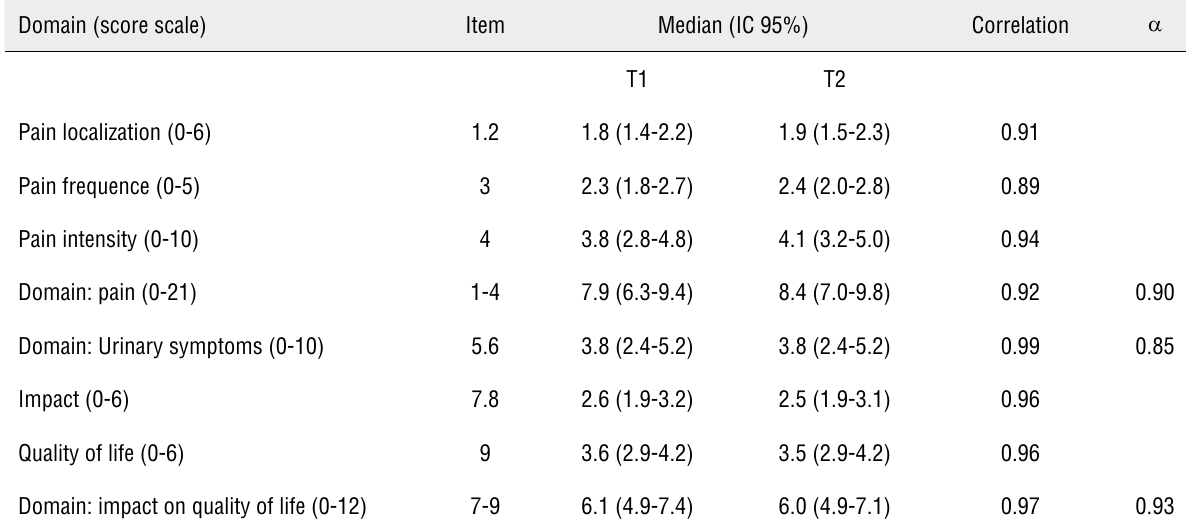
Table 2 - Reproducibility and internal consistency of NIH-CPsI